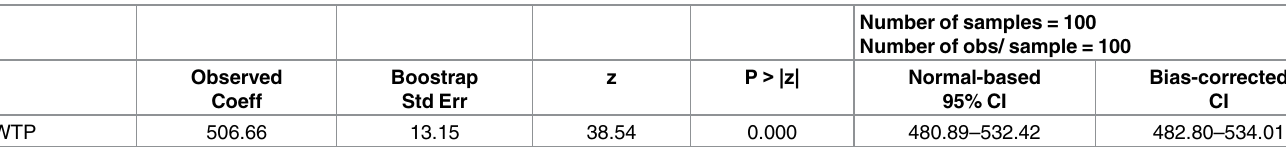
Table 11. Household willingness to pay for emptying and